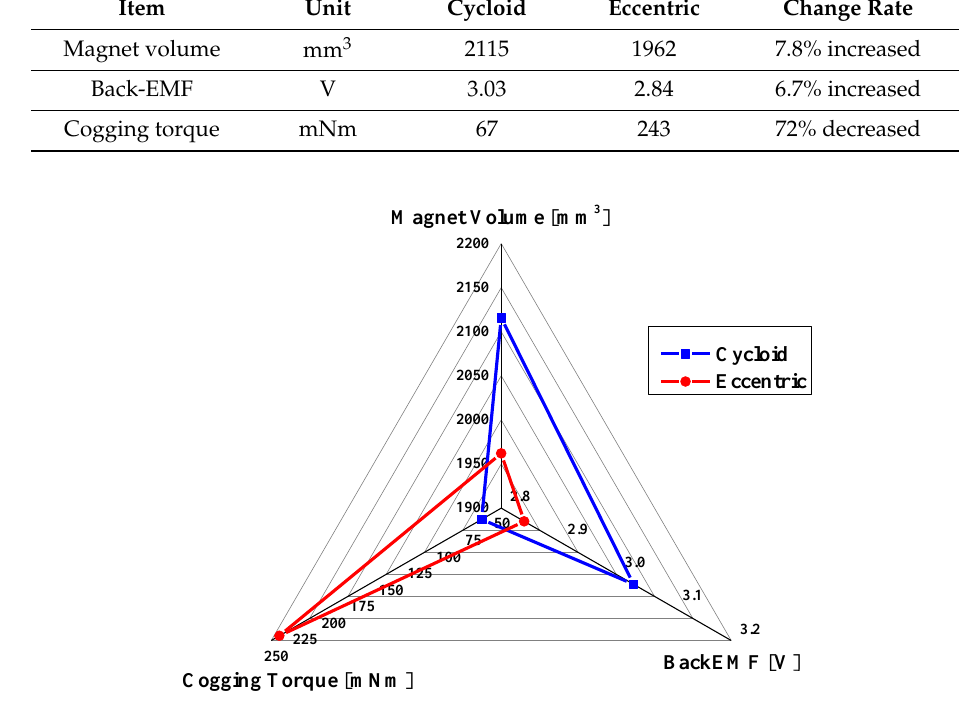
Figure 16. Back-EMF: ( a ) waveform; ( b ) harmonic order.